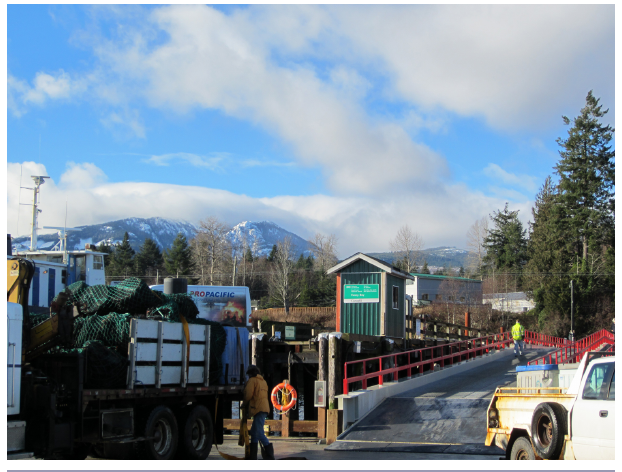
Fig. 3 . “Like” photo representing the local economic activity theme: “Okay, this picture we have a schoolhouse in the background. We have people working with scallops. And we have the mountains in the back. So the reason I like this one is because it’s sort of showing a whole community involvement. You have the children growing up learning, getting to watch sustainable activities around you. And right in the middle of beautiful nature.” (Industry